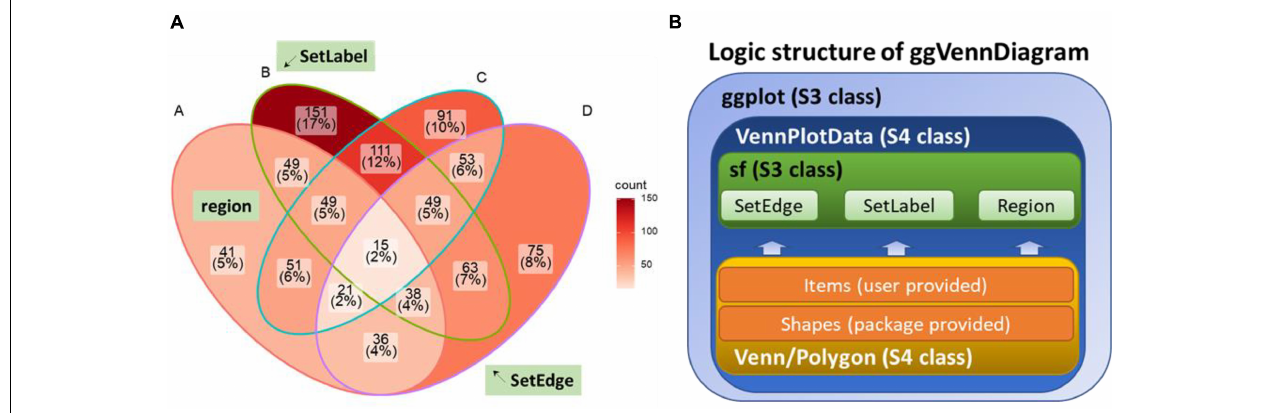
FIGURE 1 | Design of ggVennDiagram. (A) Components of a Venn diagram. SetEdge , SetLabel , and region are highlighted with a green textbox. (B) Logic structure of ggVennDiagram. The Venn diagram plotted by this package is a ggplot object that stores VennPlotData object. The VennPlotData object is further compiled by the simple features described in sf and the Venn / Polygon object introduced from RVenn.